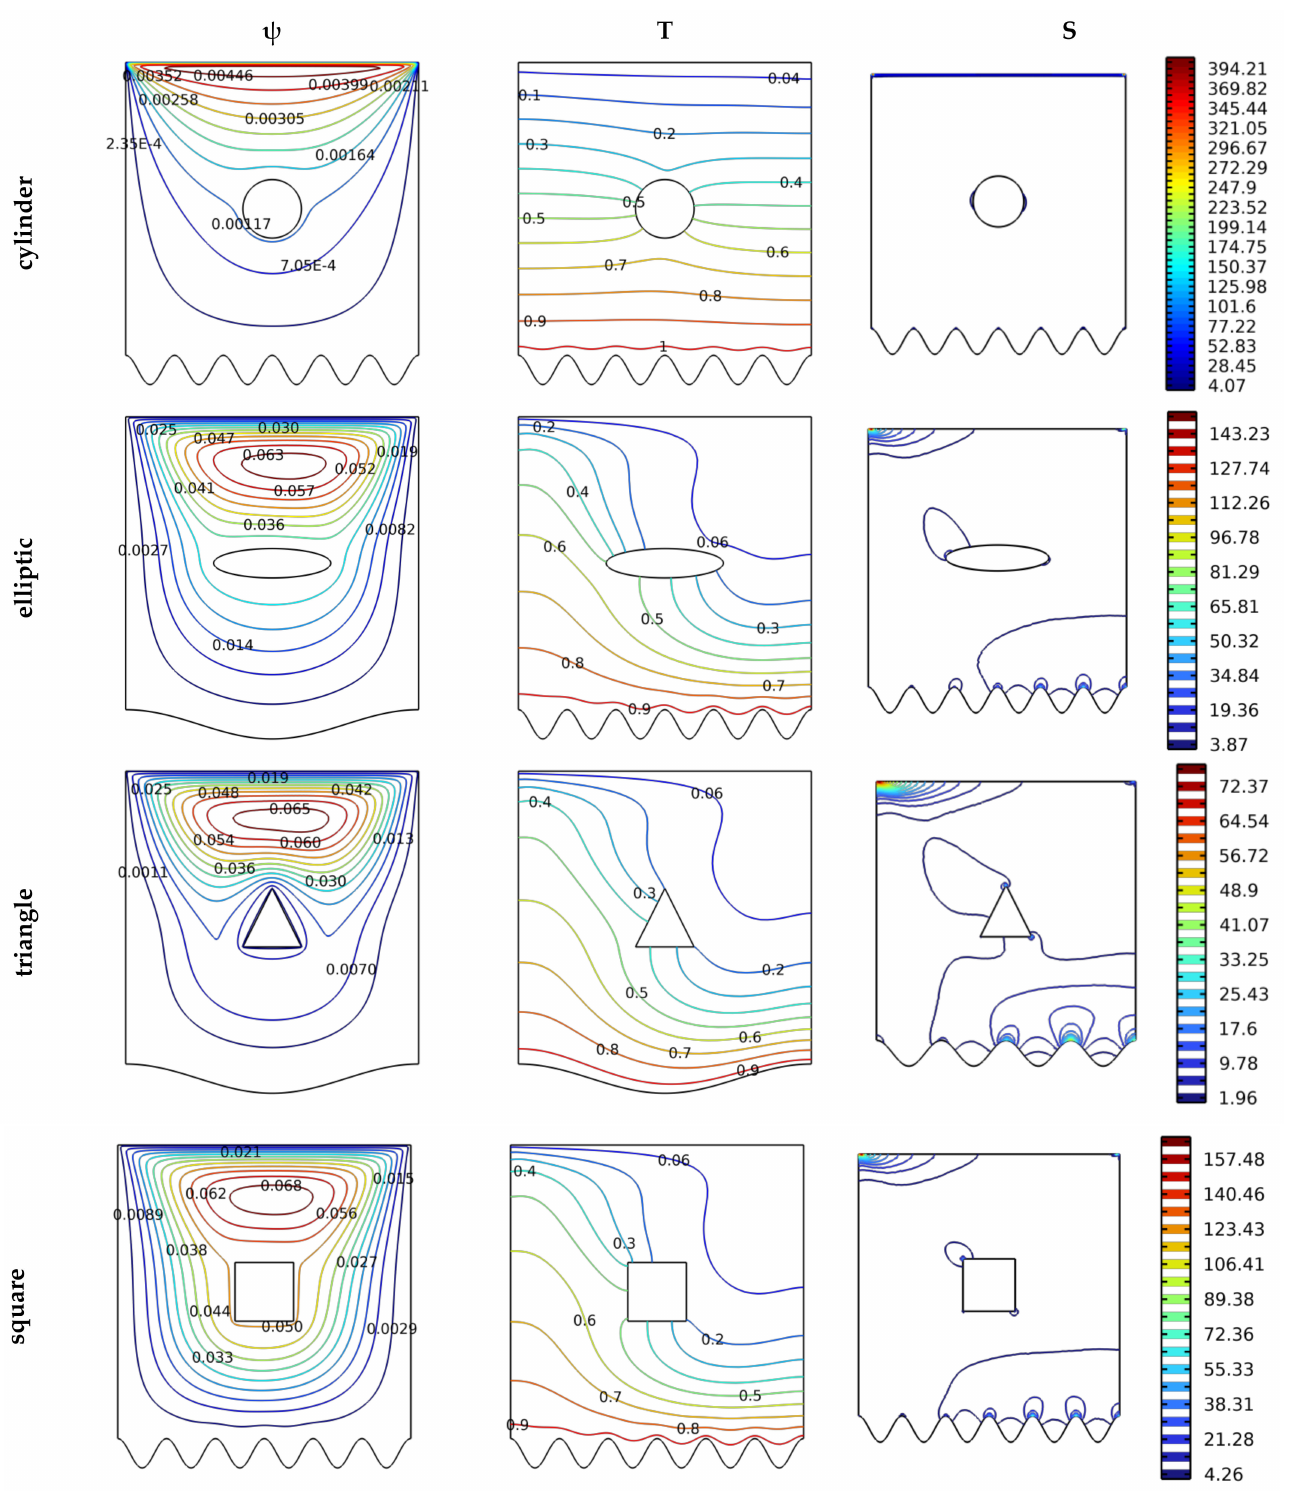
Figure 7. Distribution of streamlines, isotherms, and isentropic contours for various cases Gr = 10 3 , N = 8, and Ha =